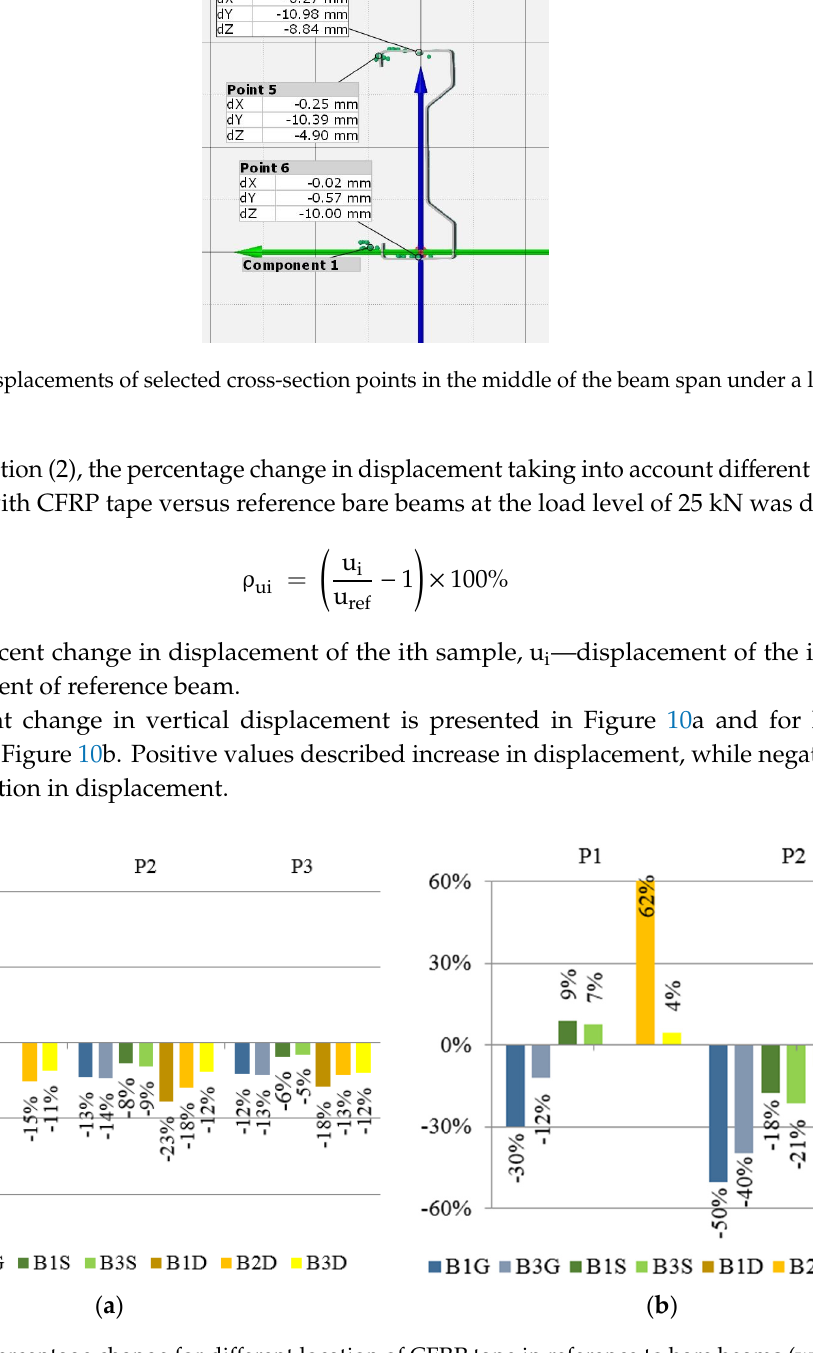
Figure 10. Percentage change for different location of CFRP tape in reference to bare beams (without reinforcement) in: ( a ) vertical displacement; ( b ) horizontal displacement. Readout from points P1, P2, and P3 at 25 kN load level.